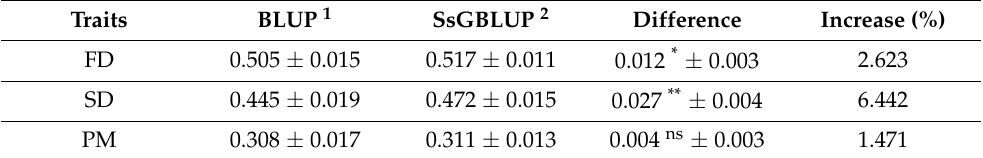
Table 3. Mean prediction accuracy ± standard error of 50 replicates of prediction accuracy of genetic values (BLUP) and genomic values (ssGBLUP), the difference in accuracy between the methods expressed as a percentage in Huacaya alpacas.